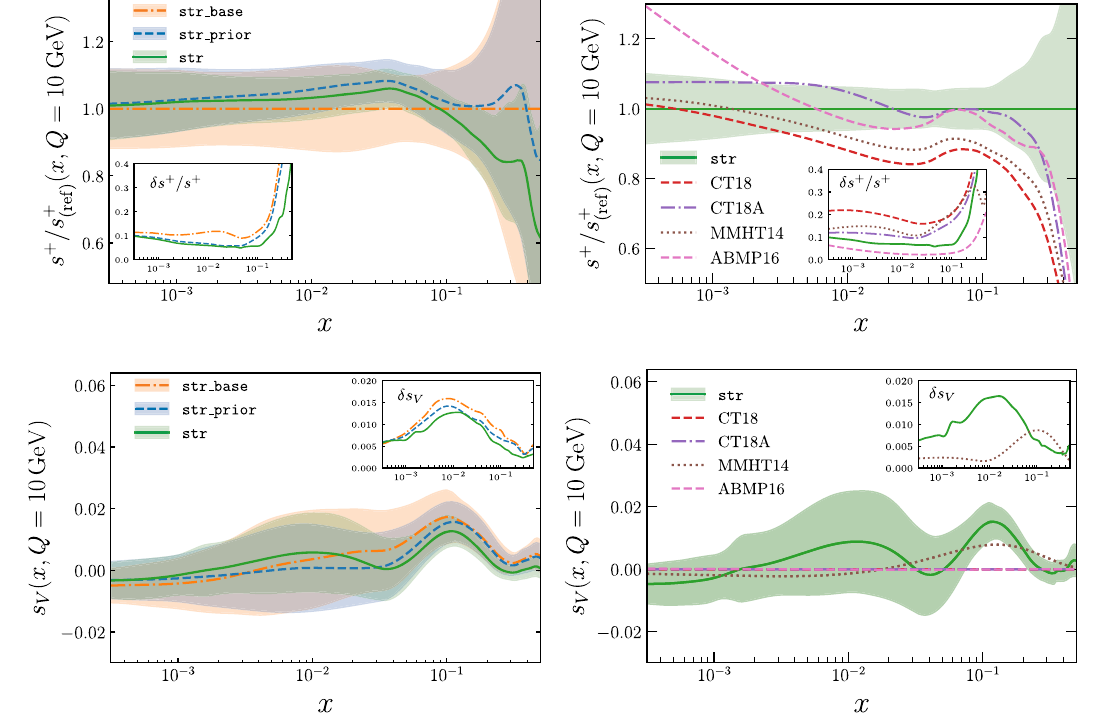
Fig. 6 A comparison of the total (top) and valence (bottom) strange distributions, s + and s V , at Q = 10 GeV. PDFs are from the str_base , str_prior and str fits (left panels) and from the str and other recent PDF fits (right panels); see the text for details. The total